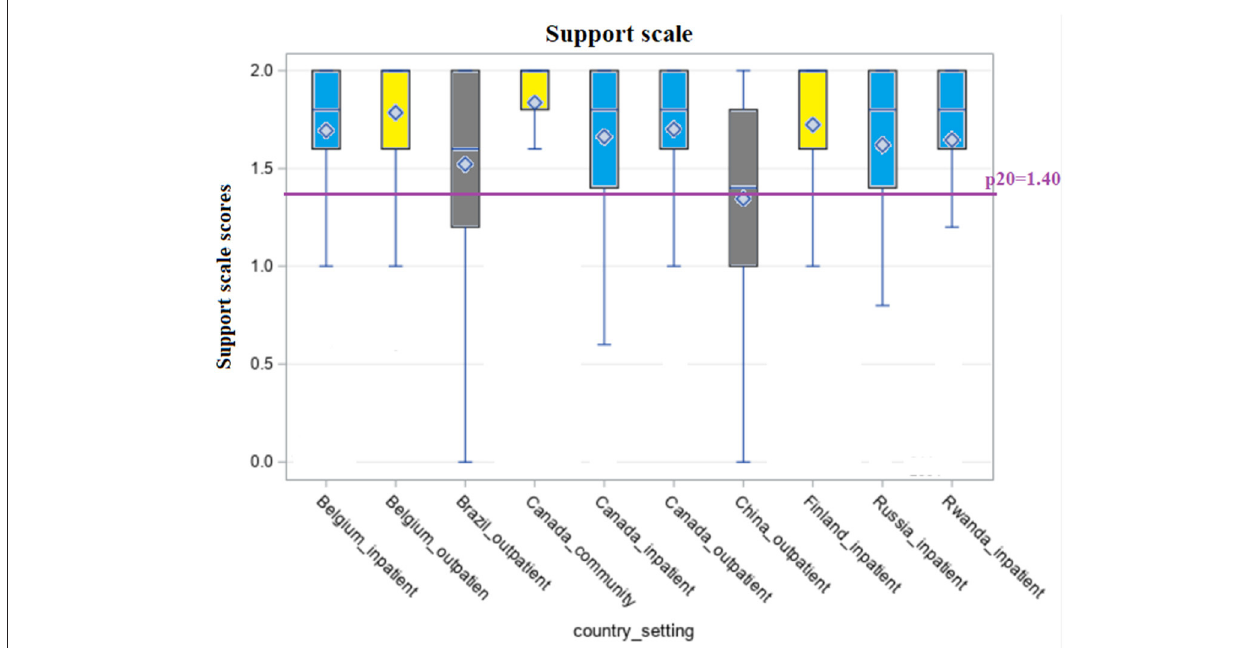
FIGURE 2 | Distribution of scores of the scale “Support” across countries and settings.